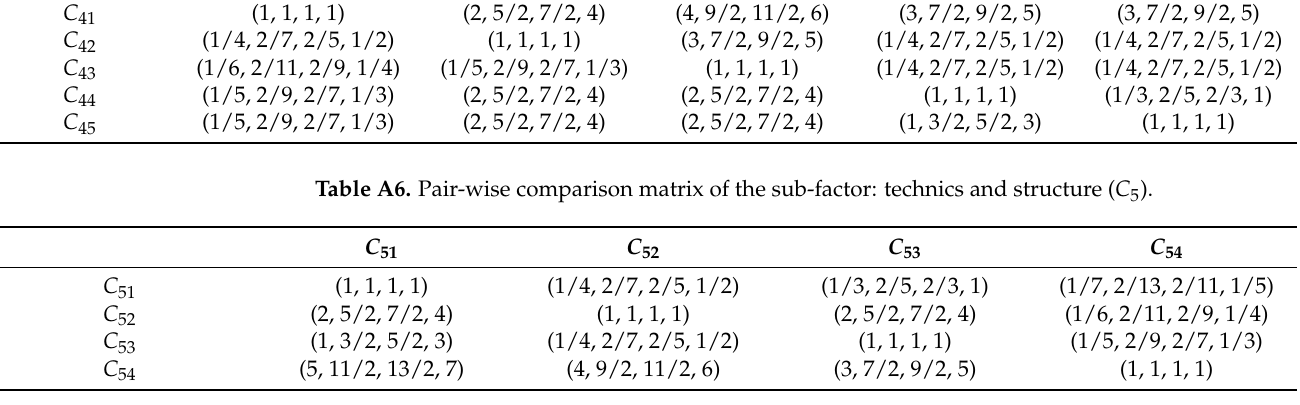
Table A7. Pair-wise comparison matrix of the sub-factor: environmental quality ( C 6